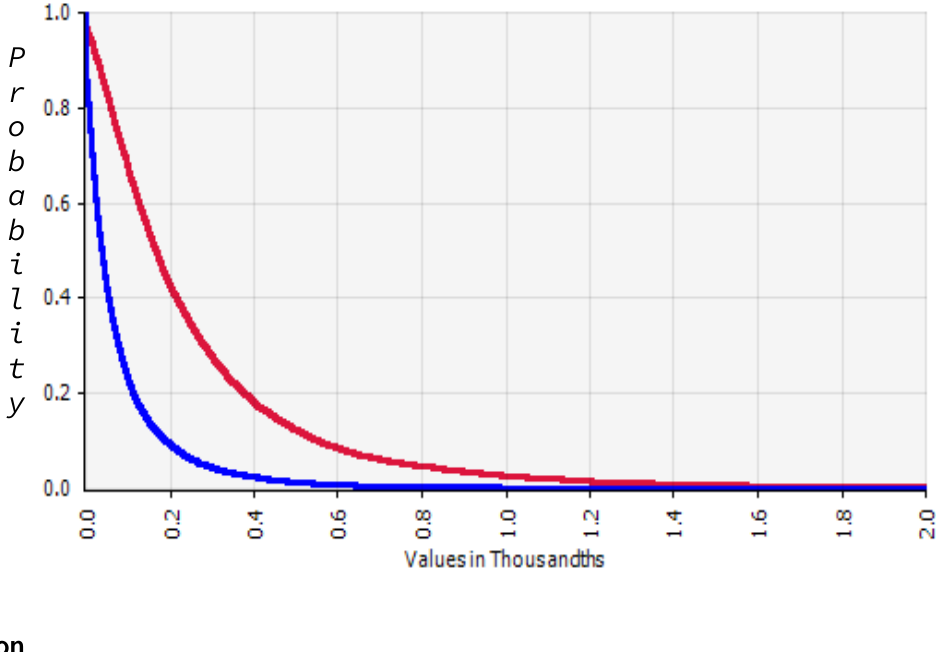
Figure 4. Skin cancer risk by using As contaminated water. Skin cancer risk with filter for Group 1 (red, R0) and Group 2 (blue,